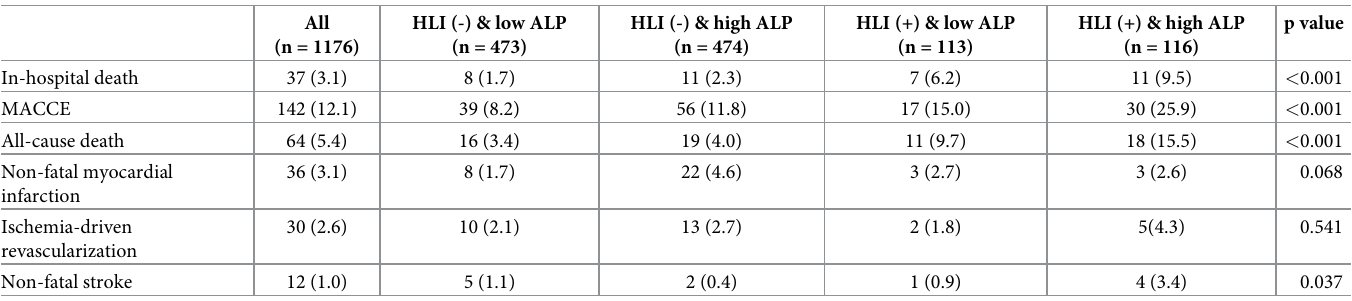
Table 3. Incidence of adverse clinical